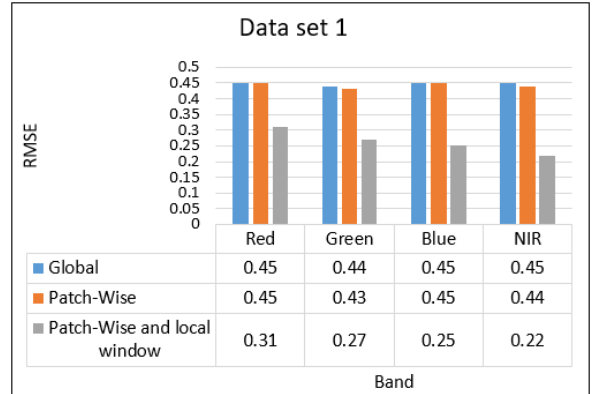
Figure 14. Final accuracy of band to band registration of the 4 bands with the reference of the red-edge band, data set 1